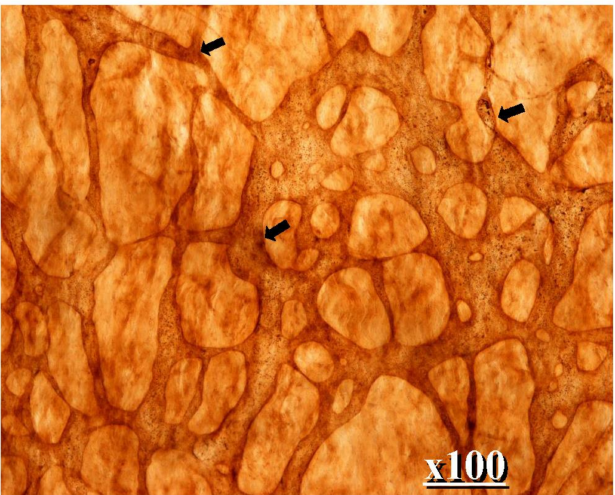
Figure 3. CH44 in submesothelial lymphatic vessels (arrow) of Morrison’s pouch.